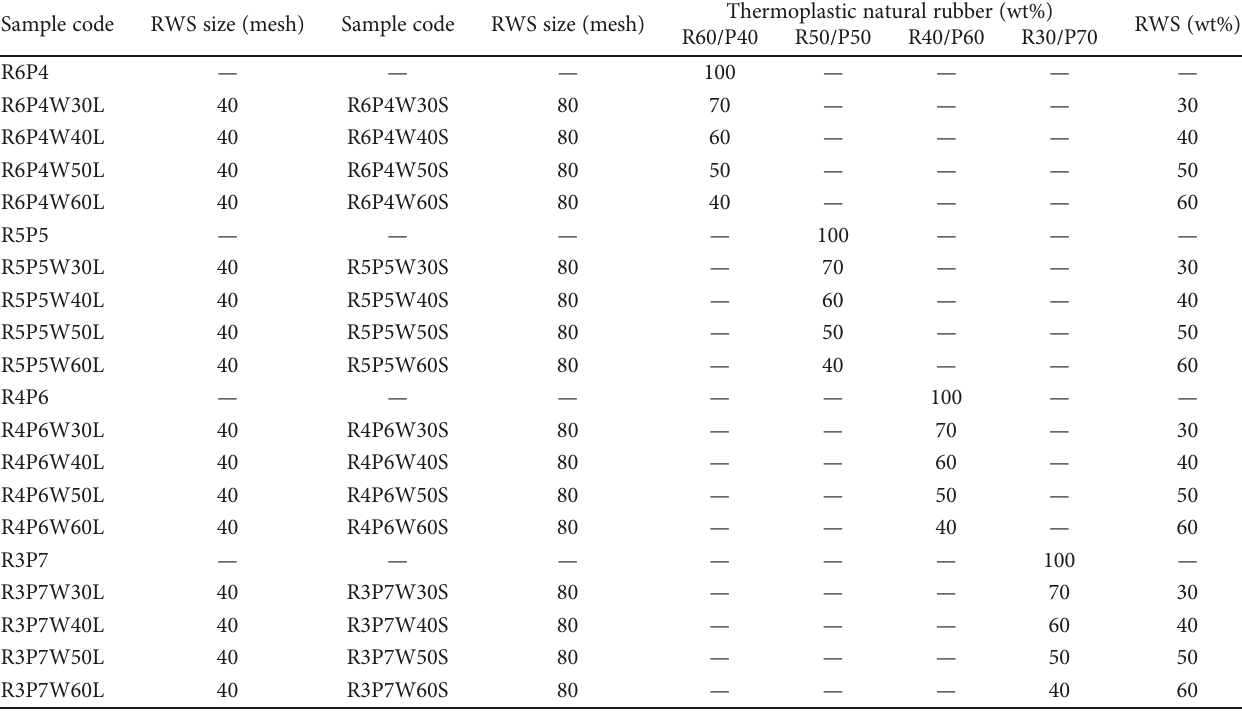
Table 1: Formulation of TPNR and TPNR/RWS composites in experiment. Sample